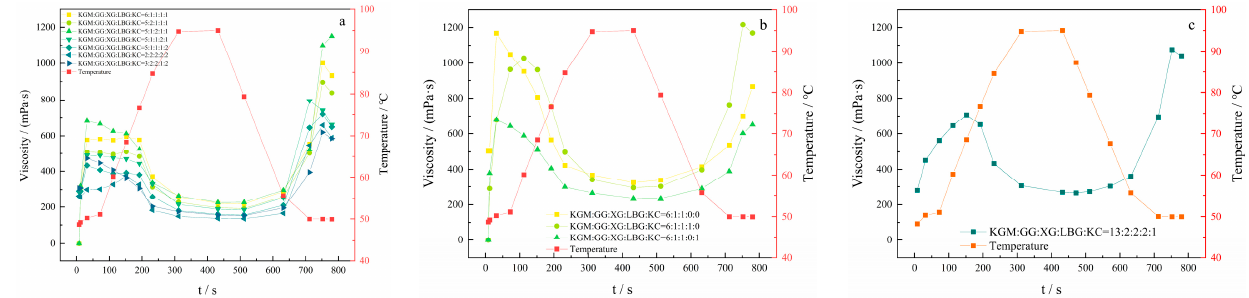
Figure 8. Viscosity curves of 5 thickeners mixed in different proportions: ( a ) the compound of KGM, GG, XG, LBG and KC; ( b ) the compound of KGM, GG, and XG; ( c ) the compound